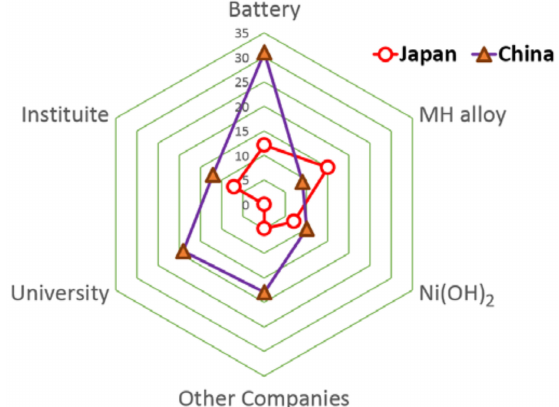
Figure 33. Areas of Patents (Applications) in ( a ) USA, ( b ) Japan, and ( c ) Chinese from negative electrode components (MH alloy), positive electrode component (nickel hydroxide), battery structure, manufacturing facilities, applications, and other areas.